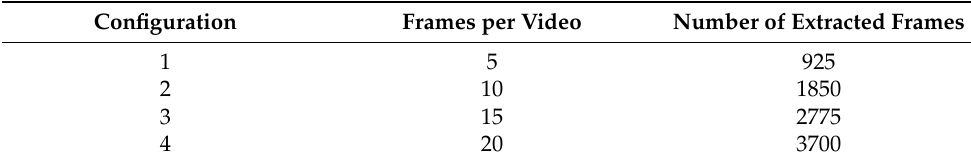
Table 4. Number of frames extracted per